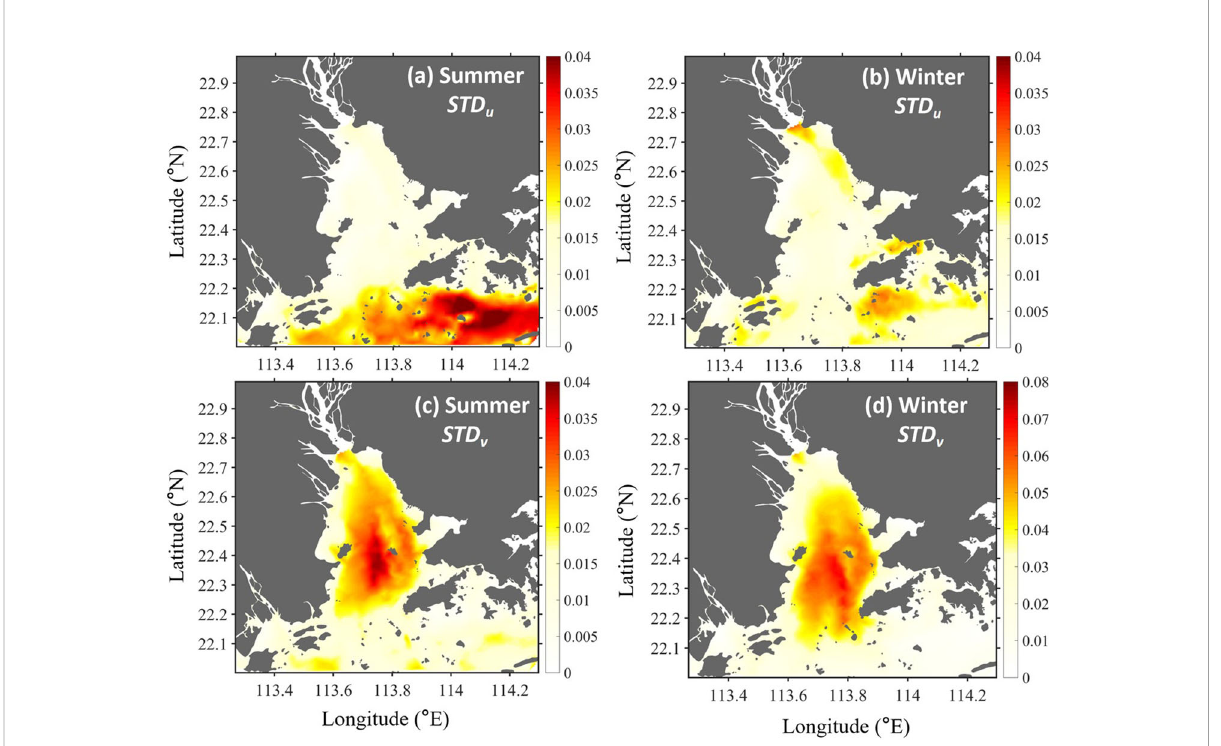
FIGURE 5 (A, B) The distribution of STD u n summer and winter, respectively; (C, D) are same as (A, B) but for STD v